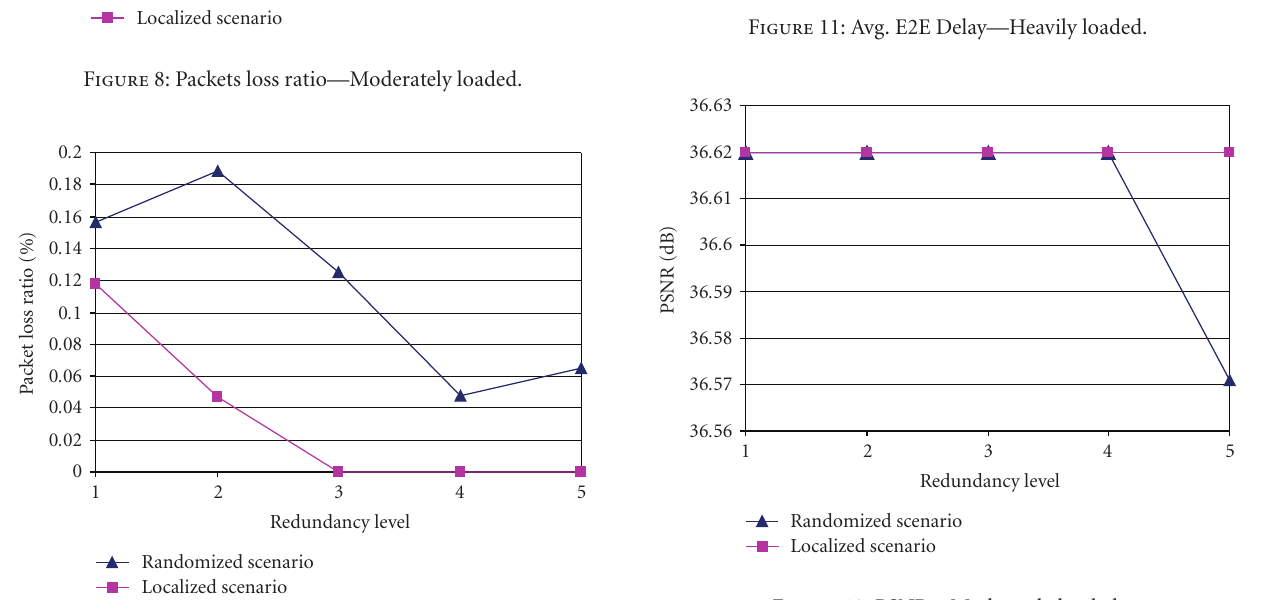
Figure 12: PSNR—Moderately loaded.